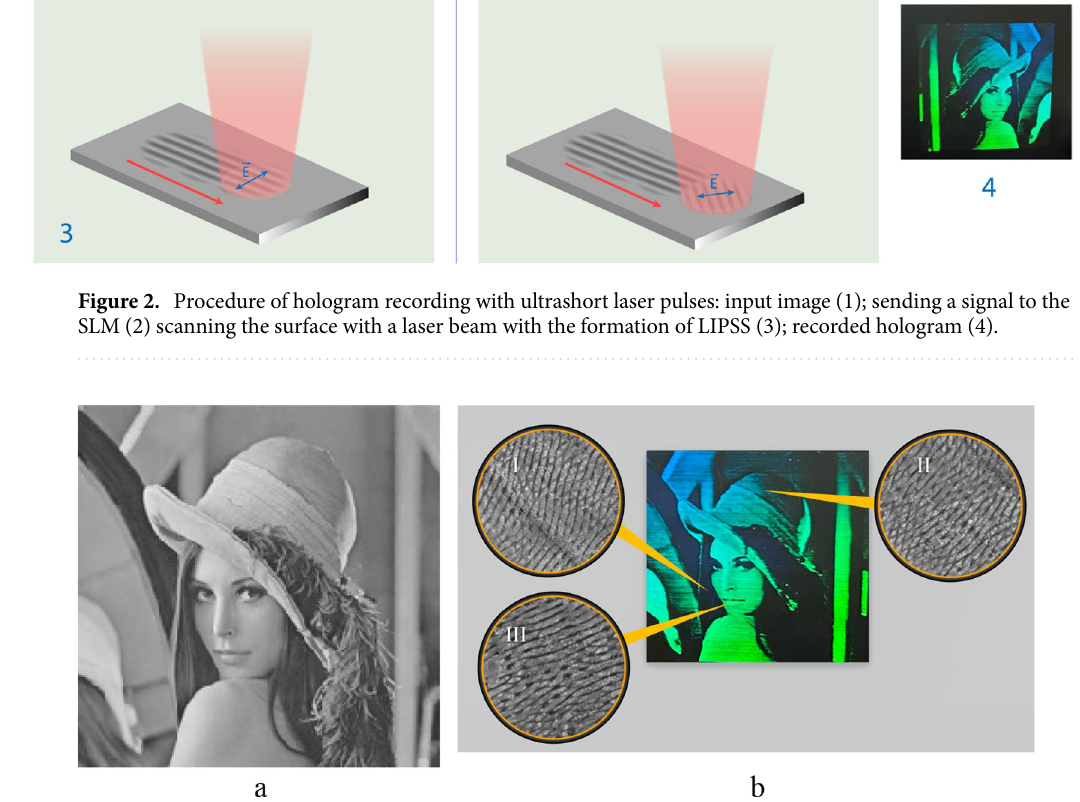
Figure 3. A bitmap image used for recording quasi-hologram ( a ). Recorded hologram with highlighted areas of low (I), intermediate (II) and high brightness level (III) ( b